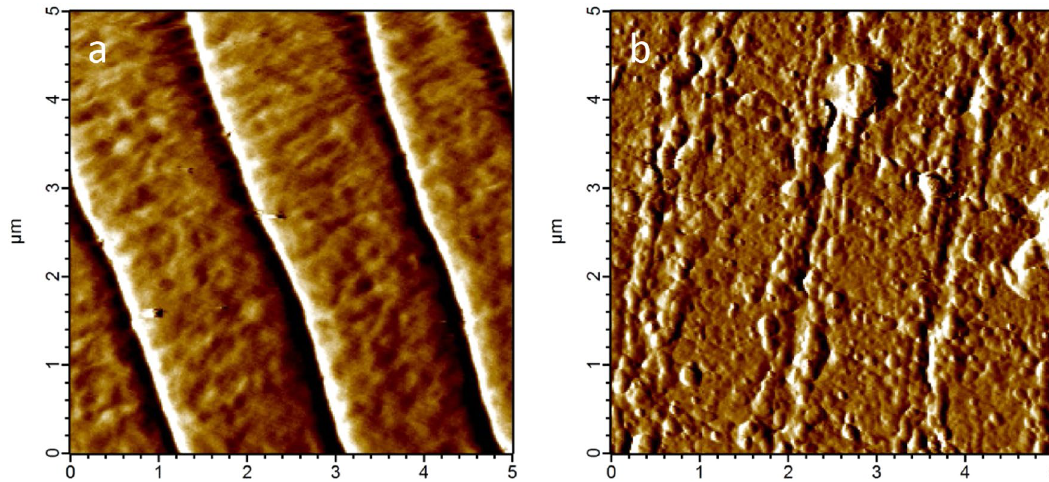
Figure 2. Topographic AFM images of the cuticle surface of young adult C. elegans after 24 h of treatment. ( a ) Untreated control, ( b ) worms treated with CM (2 mg/mL).